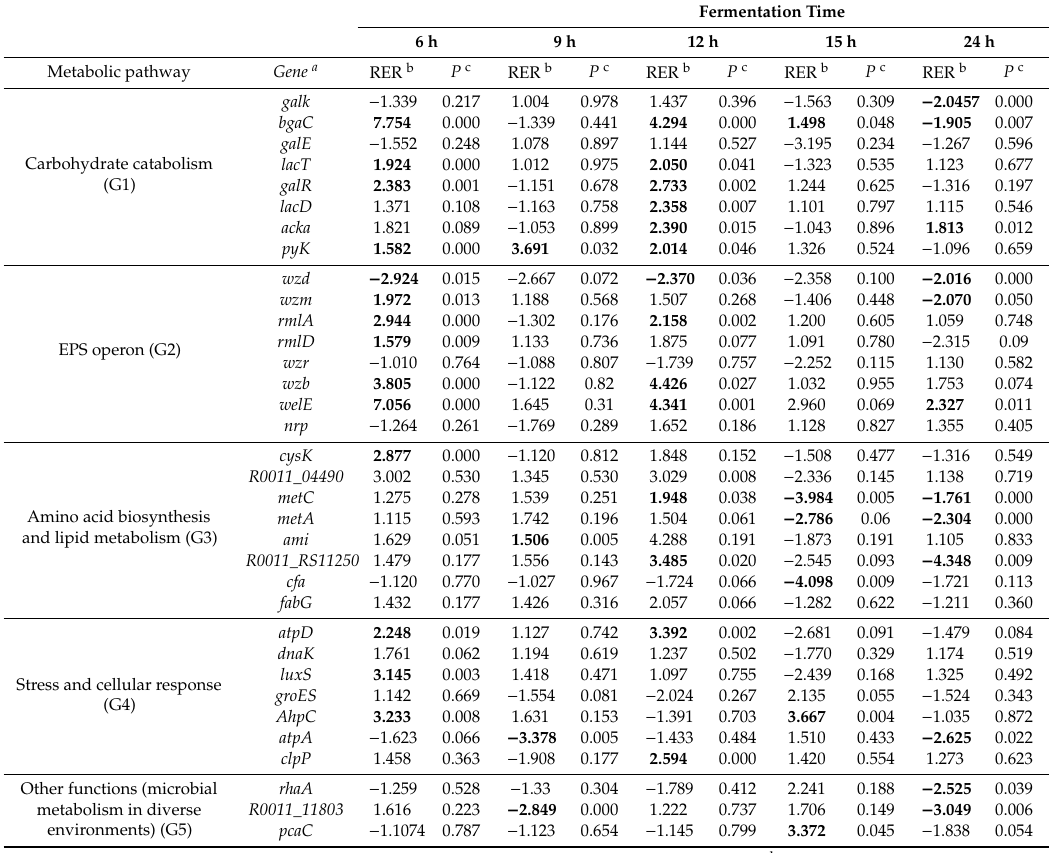
Table 1. Relative expression ratio (RER) of genes involved in carbohydrate catabolism, EPS operons, amino acid biosynthesis and lipid metabolism, stress and cellular responses and other functions (microbial metabolism in diverse environments) of L. rhamnosus R0011 over 24 h during growth in whey permeate in co-culture with S. cerevisiae